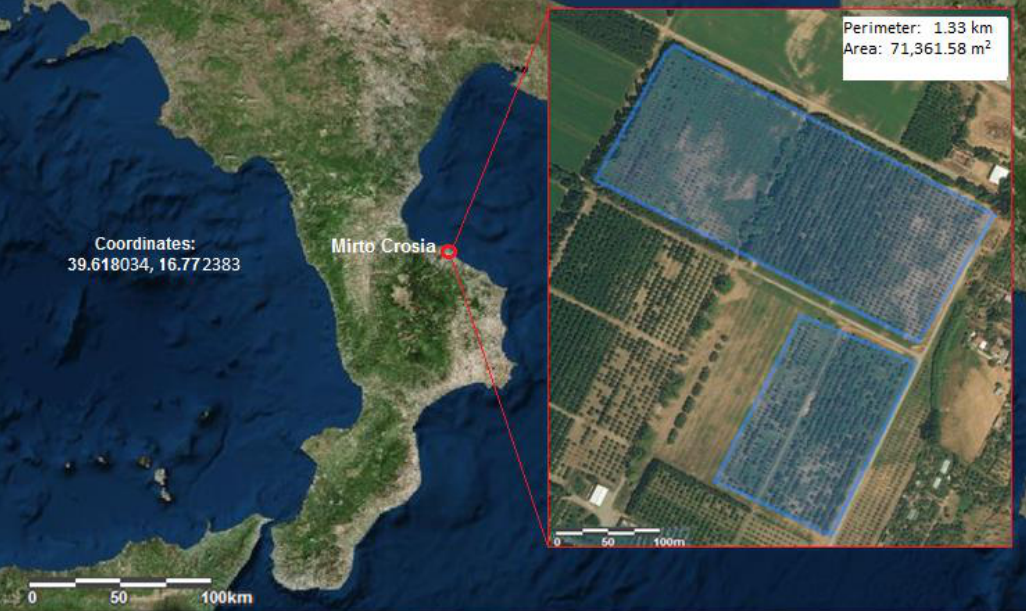
Figure 1. Geographical coordinates of the olive germplasm collection field.